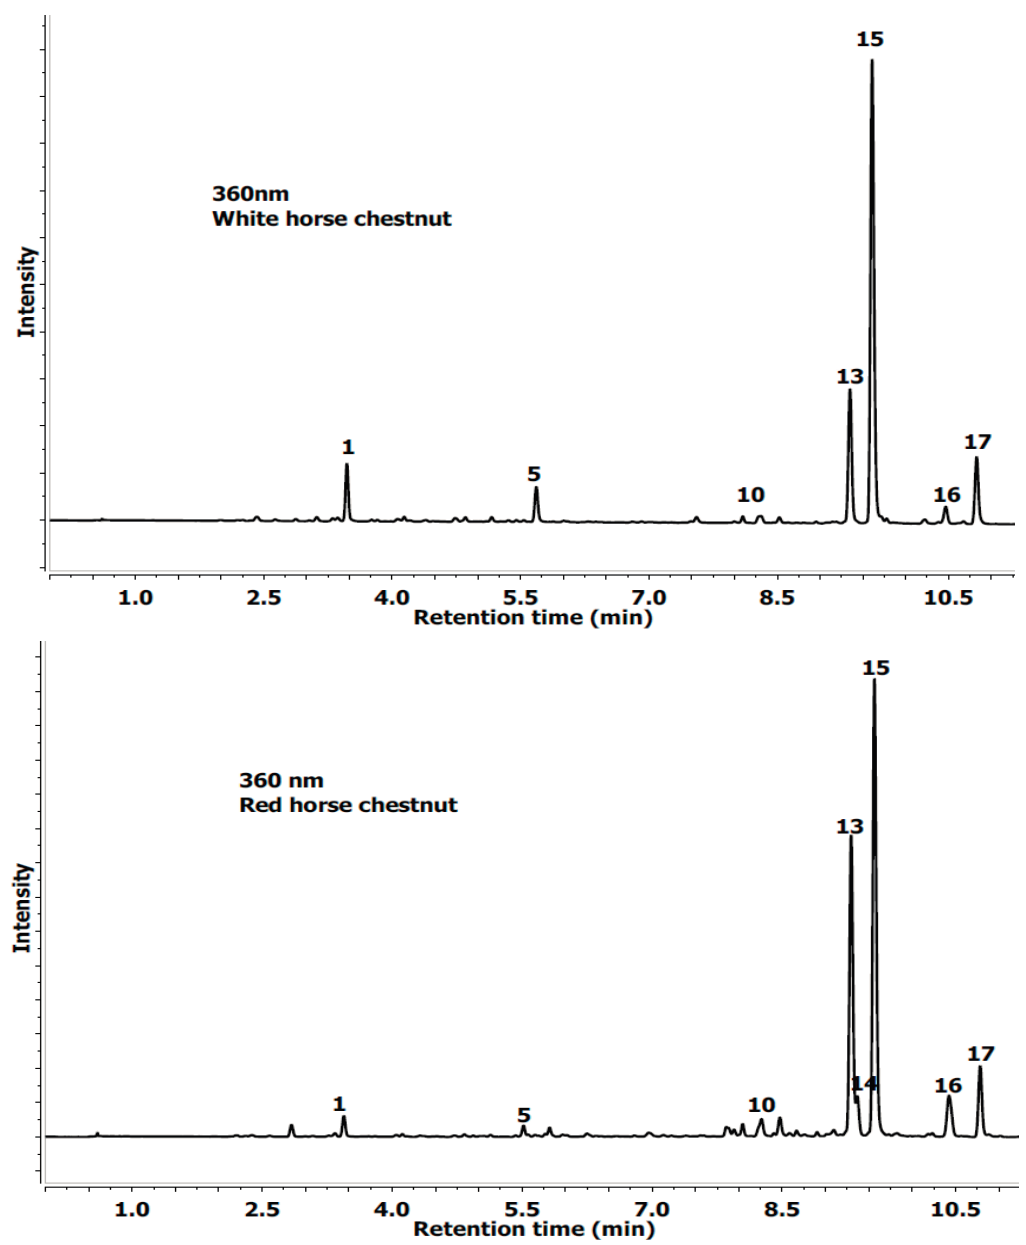
Figure 1. UPLC chromatogram profile of white and red horse chestnut leaves extracts at 360 nm (phenolic acid and quercetin derivative). Abbreviations for peak labels see Table